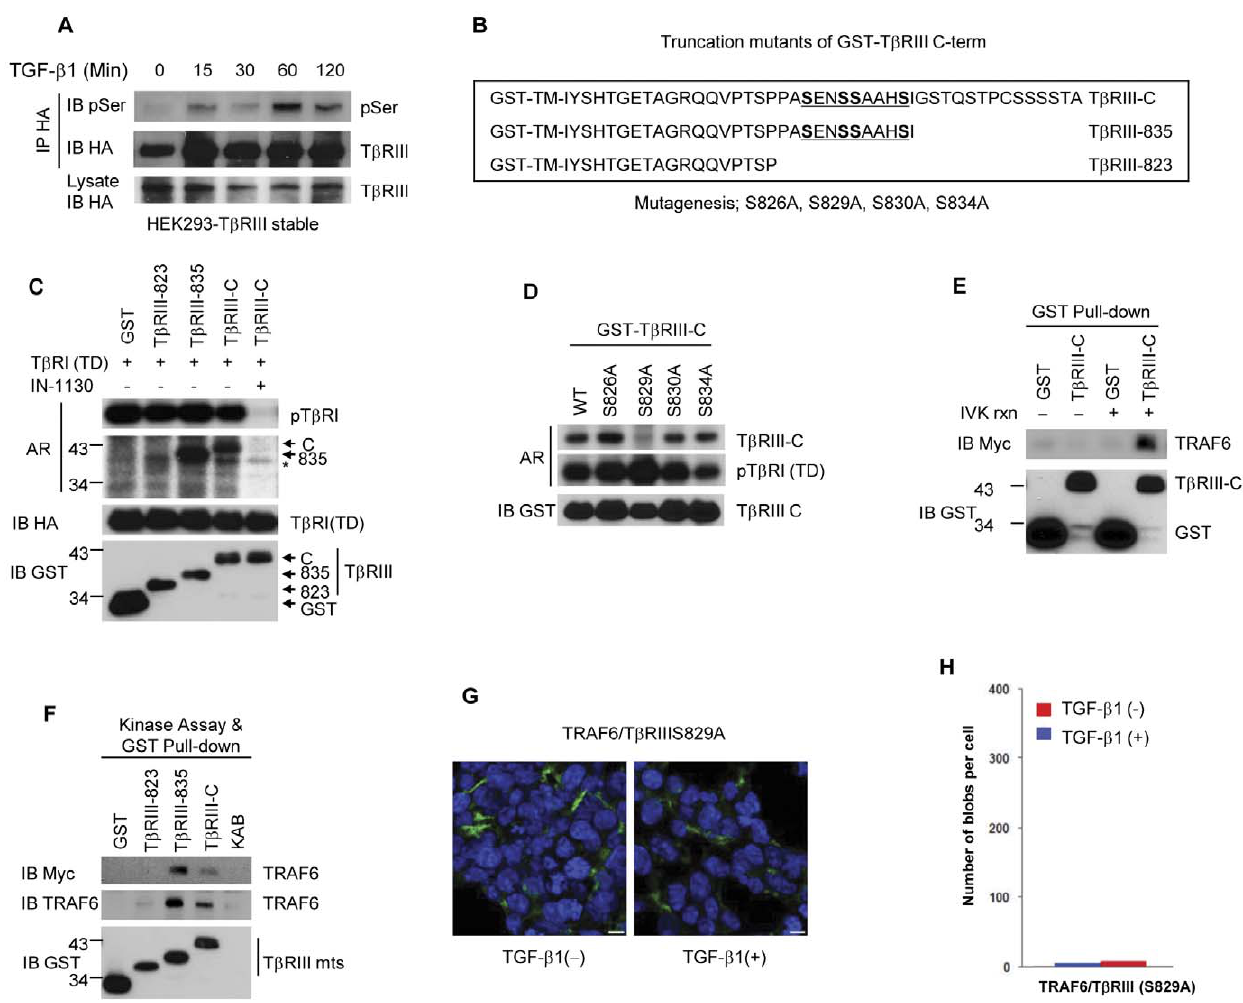
Figure 5. T b RI-mediated phosphorylation of T b RIII at Ser 829 induces preferential binding to TRAF6. ( A ) HEK293 cells stably expressing T b RIII were treated with TGF- b 1 over a time course. HA-tagged T b RIII was purified by immunoprecipitation and evaluated the change in serine phosphorylation. ( B ) The transmembrane (TM) and cytoplasmic domains of T b RIII were fused with GST protein. Amino acid sequences for cytoplasmic full-length (T b RIII-C) and deletion mutants (T b RIII-835, T b RIII-823) of GST-T b RIII fusion proteins are illustrated. The potential phosphorylation sites are underlined, and were substituted from Ser to Ala for subsequent experiments. ( C ) Equal amounts of GST-T b RIII-C and deletion mutants were subjected to in vitro kinase assay using constitutively active T b RI (TD). IN-1130 (1 m M), a specific inhibitor of T b RI, was added to demonstrate the specificity of kinase reactions. ( D ) The potential phosphorylation sites on GST-T b RIII were mutated to Ala and determined the T b RI (TD)-mediated phosphorylation site of T b RIII. ( E ) A GST pull-down assay was performed using GST-tagged T b RIII-C deletion mutant against cell lysates expressing Myc-TRAF6 proteins. The phosphorylation by T b RI (TD) significantly increased T b RIII and TRAF6 interaction in vitro . ( F ) GST-tagged T b RIII-C deletion mutants, subjected to an in vitro T b RI (TD) kinase assay, were used to define the region of T b RIII that interacts with TRAF6. ( G ) O-link assay was conducted for visualization of interaction between TRAF6 and T b RIIIS829A in HEK 293T cells. Bar=2.5 m m. ( H ) The number of in situ PLA signals per cell was counted by semi-automated image analysis. The results are representative of three independent